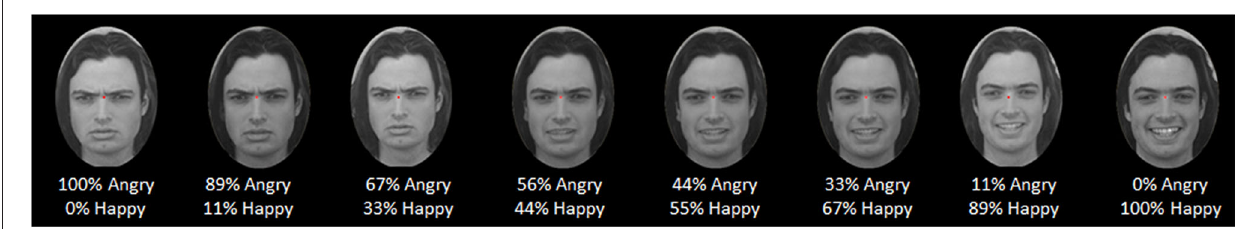
FIGURE 2 | Example of morph stimuli used in the experiments . The original stimuli (AM01) were taken from the KDEF database (Lundqvist et al., 1998). In this example stimuli are comprised from angry and happy faces morphed together to create a continuum of